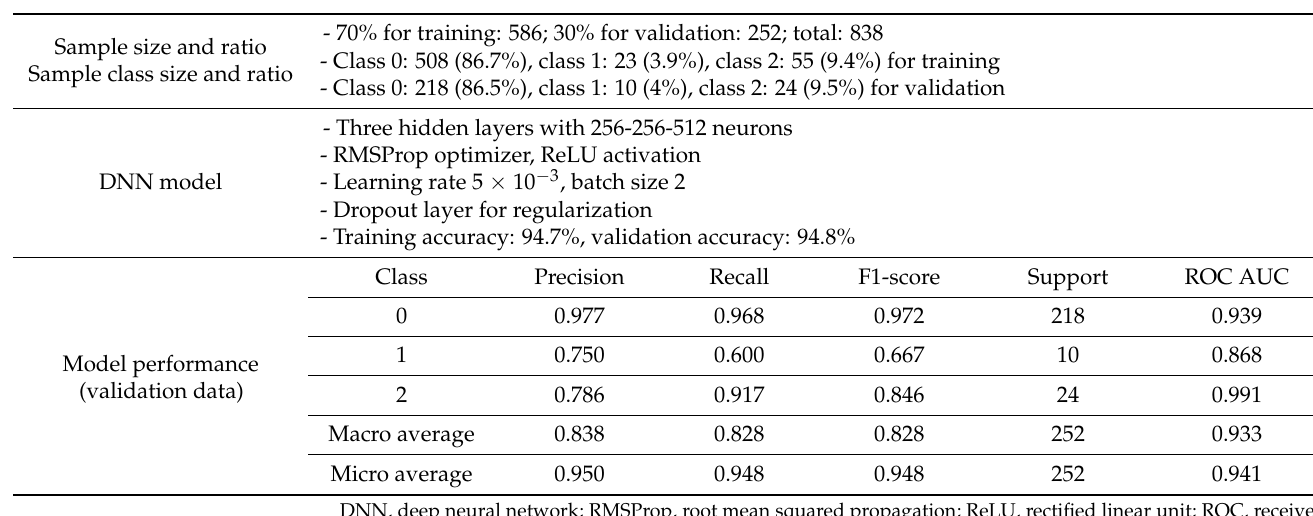
Table 3. Details of the model for determining the application of entire